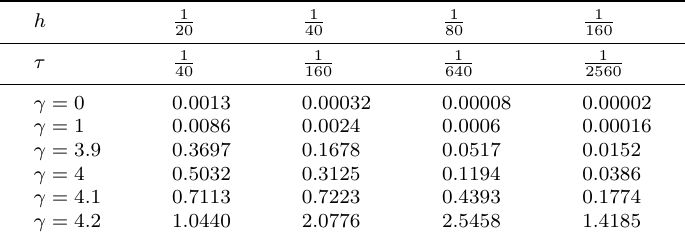
Table 2. The errors of solution in the case q ( x,y ) = 0, a = 0 . 5, T = 1; stability condition (4.3) is γ <